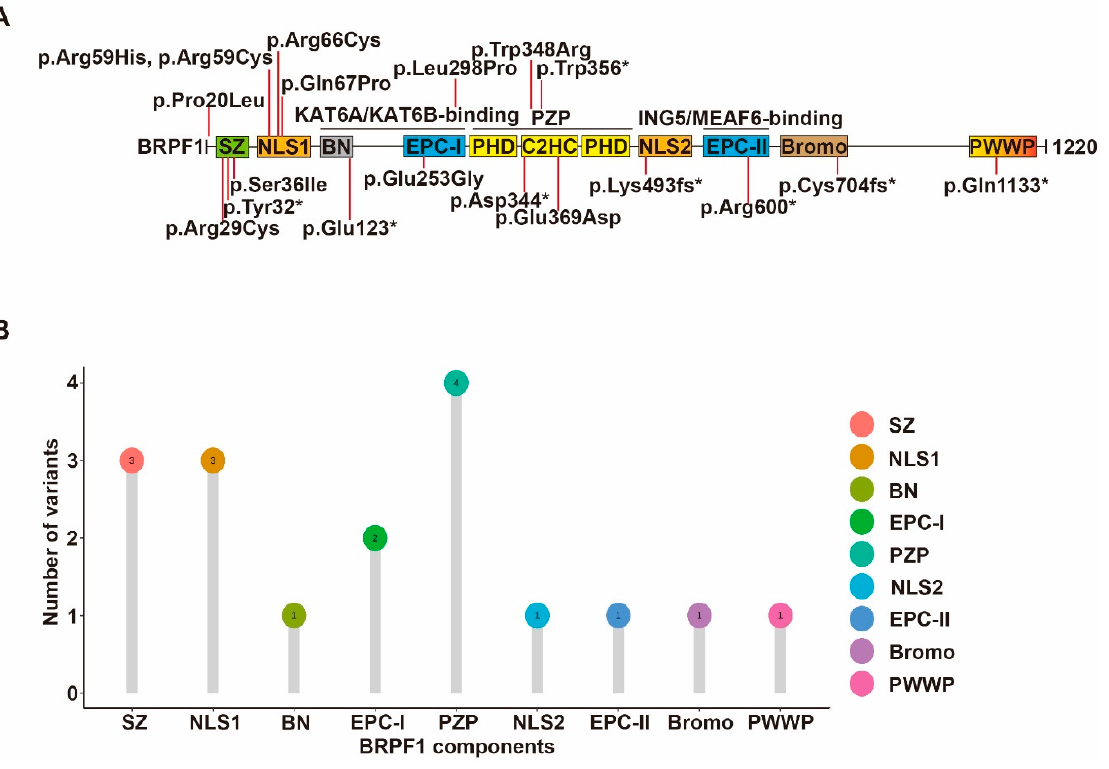
Figure 4. Cancer-associated BRPF1 somatic mutants. ( A ) Cartoon illustration of somatic variants of BRPF1 identified in cancer. See Figure 1 for domain nomenclature. ( B ) Lollipop graph demonstrating the distribution of cancer-associated BRPF1 variants.